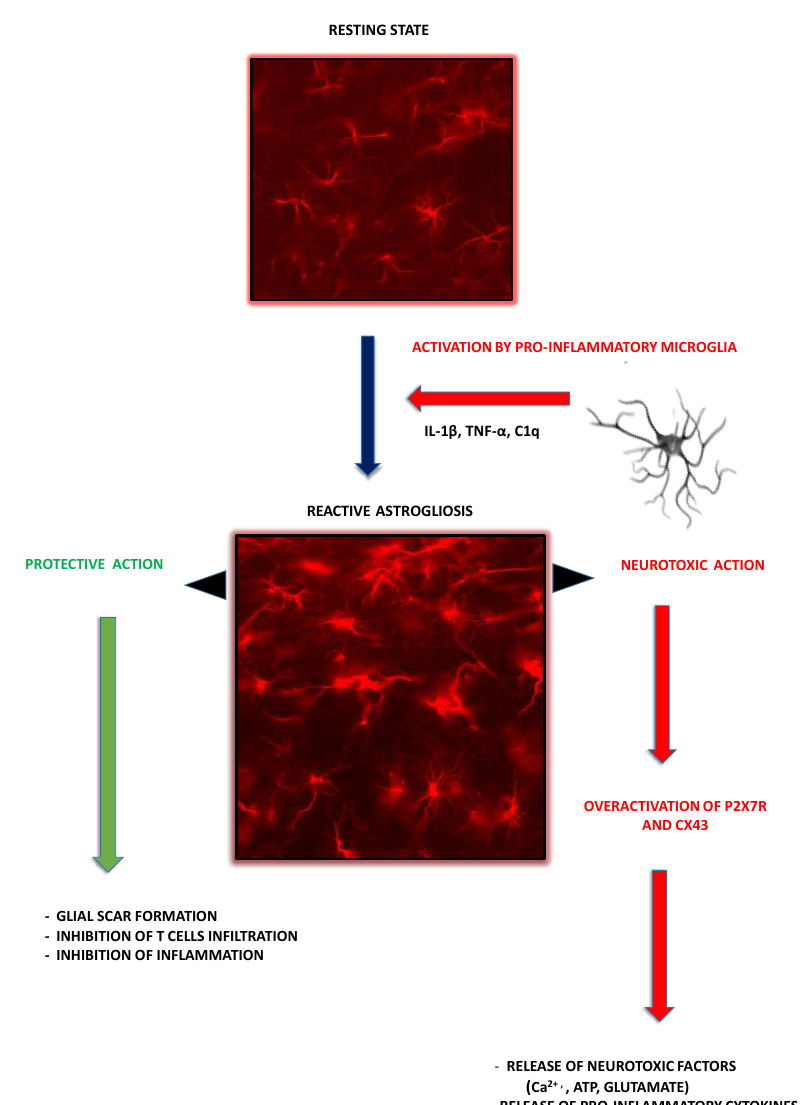
Figure 2 . Schematic representation of the protective and negative roles of astroglia and their P2XR in MS pathology. Activated astrocytes overexpress P2X7R whose overactivation mediates efflux of neurotoxic factors such as extracellular ATP, calcium ions (Ca 2+ ) and glutamate, as well as proin- flammatory cytokines and chemokines that exacerbate neuroinflammation. In parallel, protective functions of reactive astroglia may be activated that are relevant to the processes of glial scar for- mation and remyelination. (green arrows indicate protective effects, red arrows indicate negative effects). See text for details.